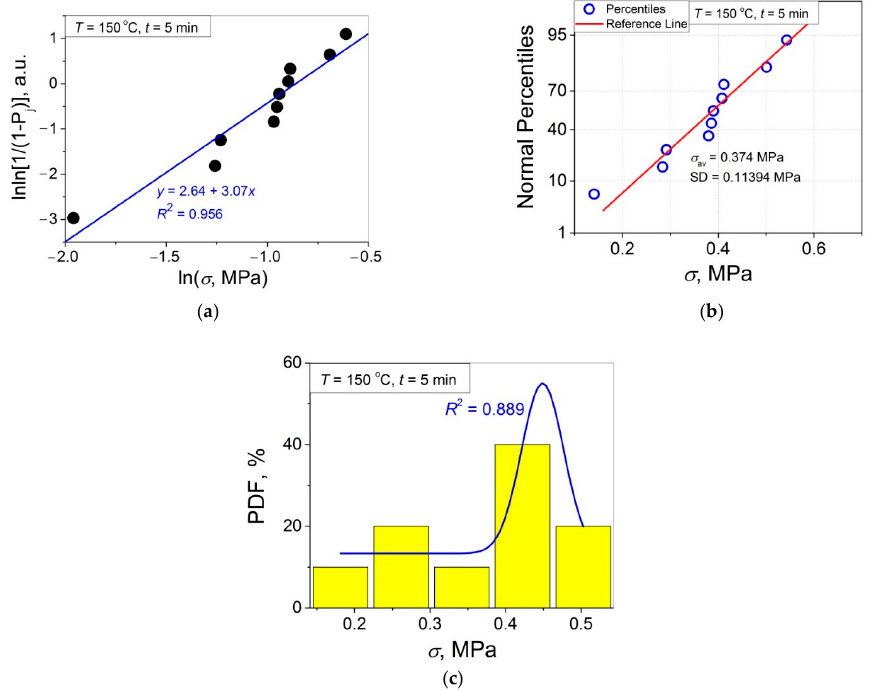
Figure 11. ( a ) Linear regression fit of the lap shear strength σ in Weibull’s coordinates; ( b ) normal probability plot; ( c ) probability density function (PDF) vs. σ fitted with a Gaussian function for an amorphous PET–PET interface self-bonded at T = 150 °C for t = 5 min.